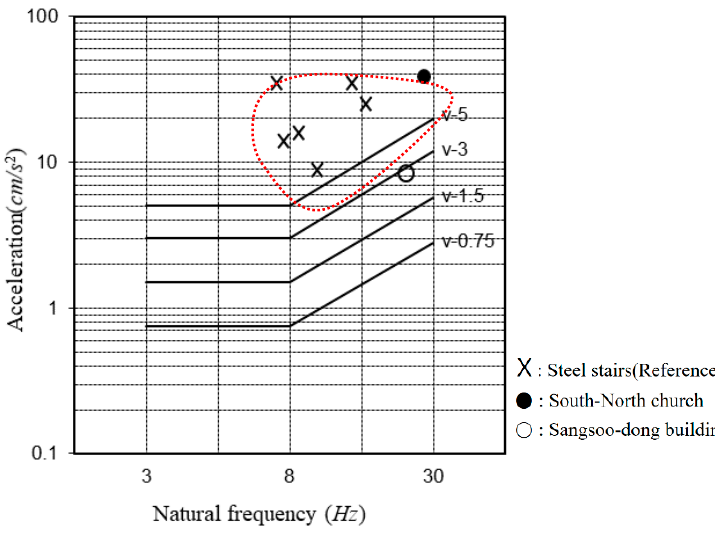
Figure 19. Vibration evaluation curve based on the Architecture Institute of Japan standard [11].